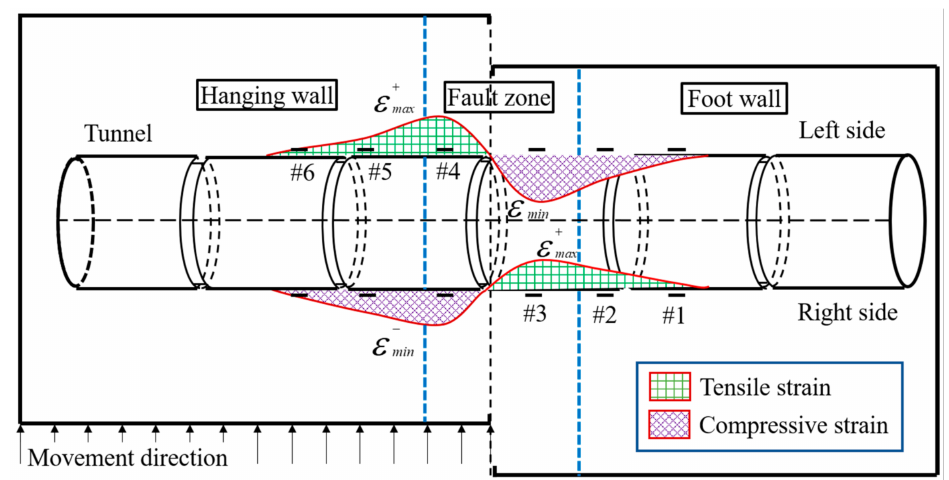
Figure 12. Schematic diagram of strain response of the lining under strike-slip fault dislocation. 3.2.2. Deformation and Damage Pattern of the Tunnel Structure The deformation and failure of a tunnel with flexible joints subjected to the strike-slip fault zone for each case are shown in Figures 13 and 14.